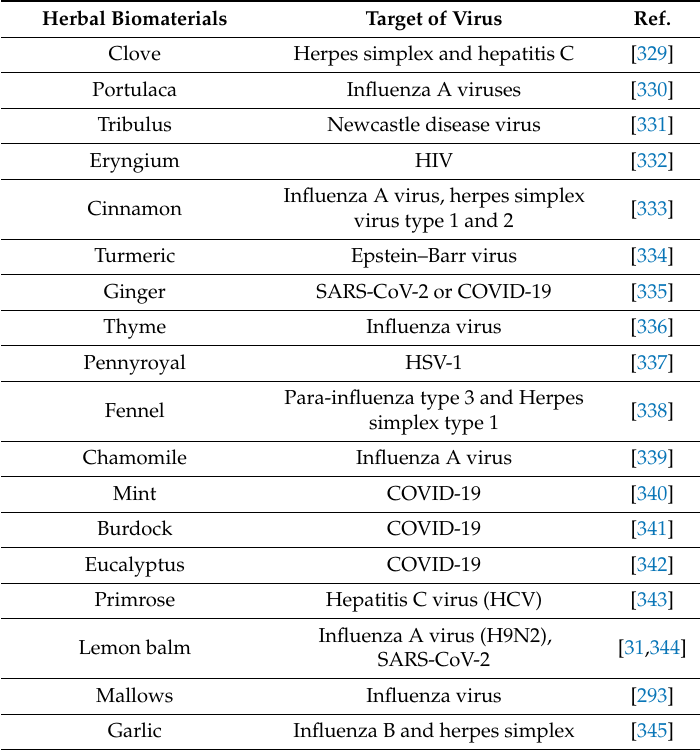
Table 3. Antiviral activity of herbal materials and their virus